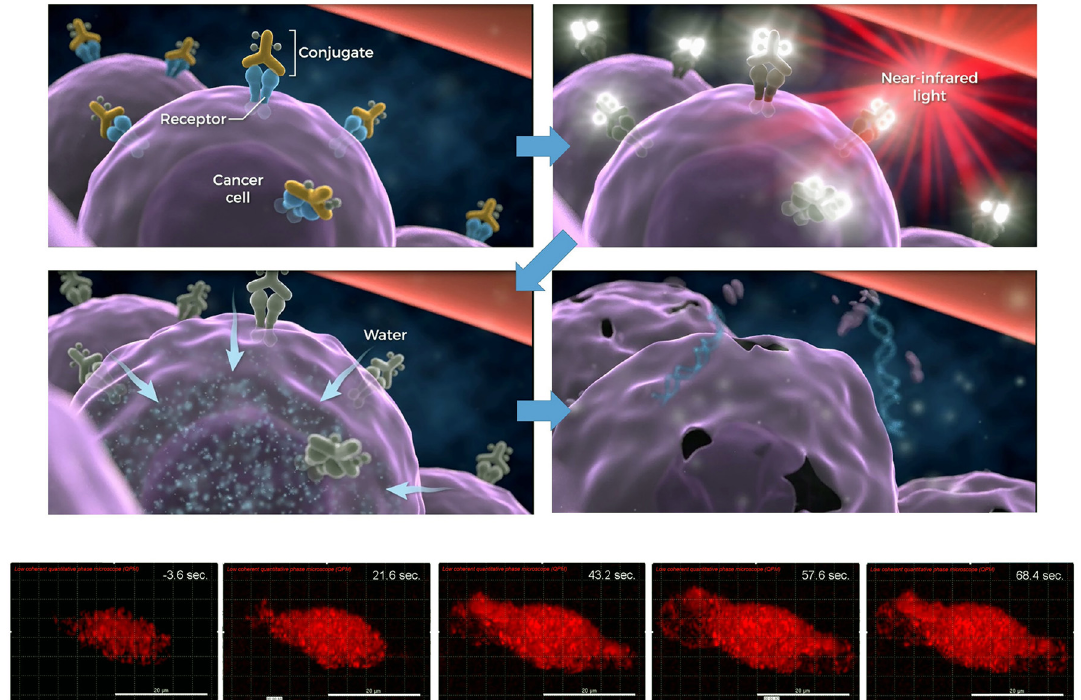
Figure 11: Cartoon visualization of the photoinduced damages on the cell membrane and the subsequent entry of solvent molecules upon permeabilization. The bottom line shows time - lapse images for cellular cytotoxicity induced by NIR - PIT. Reproduced from ref. [ 165 ] . https:// pubs.acs.org/doi/10.1021/acs.accounts.9b00273. Further permission related to the material excerpted should be directed to the